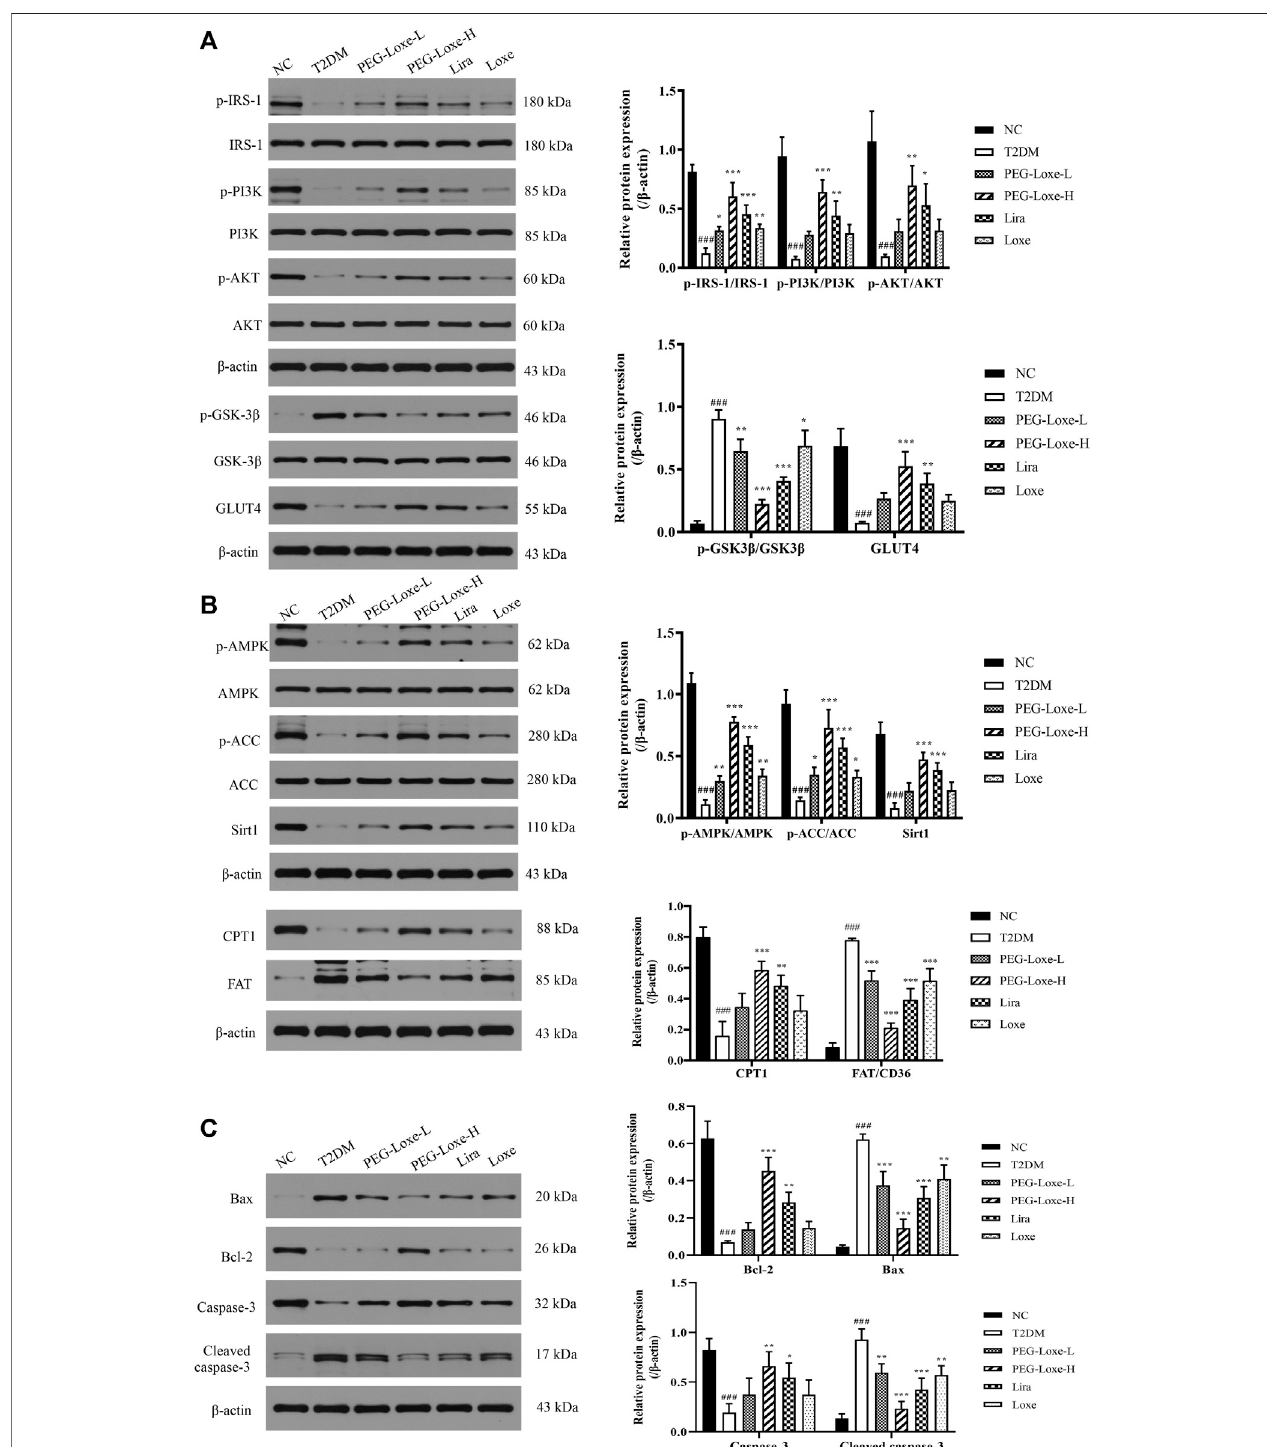
FIGURE 5 | Polyethylene glycol loxenatide (PEG-Loxe) regulates the expressions of the Sirt1-AMPK pathway-, insulin PI3K/AKT pathway- and apoptosis-related proteins. Protein expression levels were normalized to the levels of β -actin. Data are presented as the mean ± SD; n (cid:2) 3; ### p < 0.001 compared to the normal control group; * p < 0.05, ** p < 0.01, and *** p < 0.001 compared to the T2DM group.